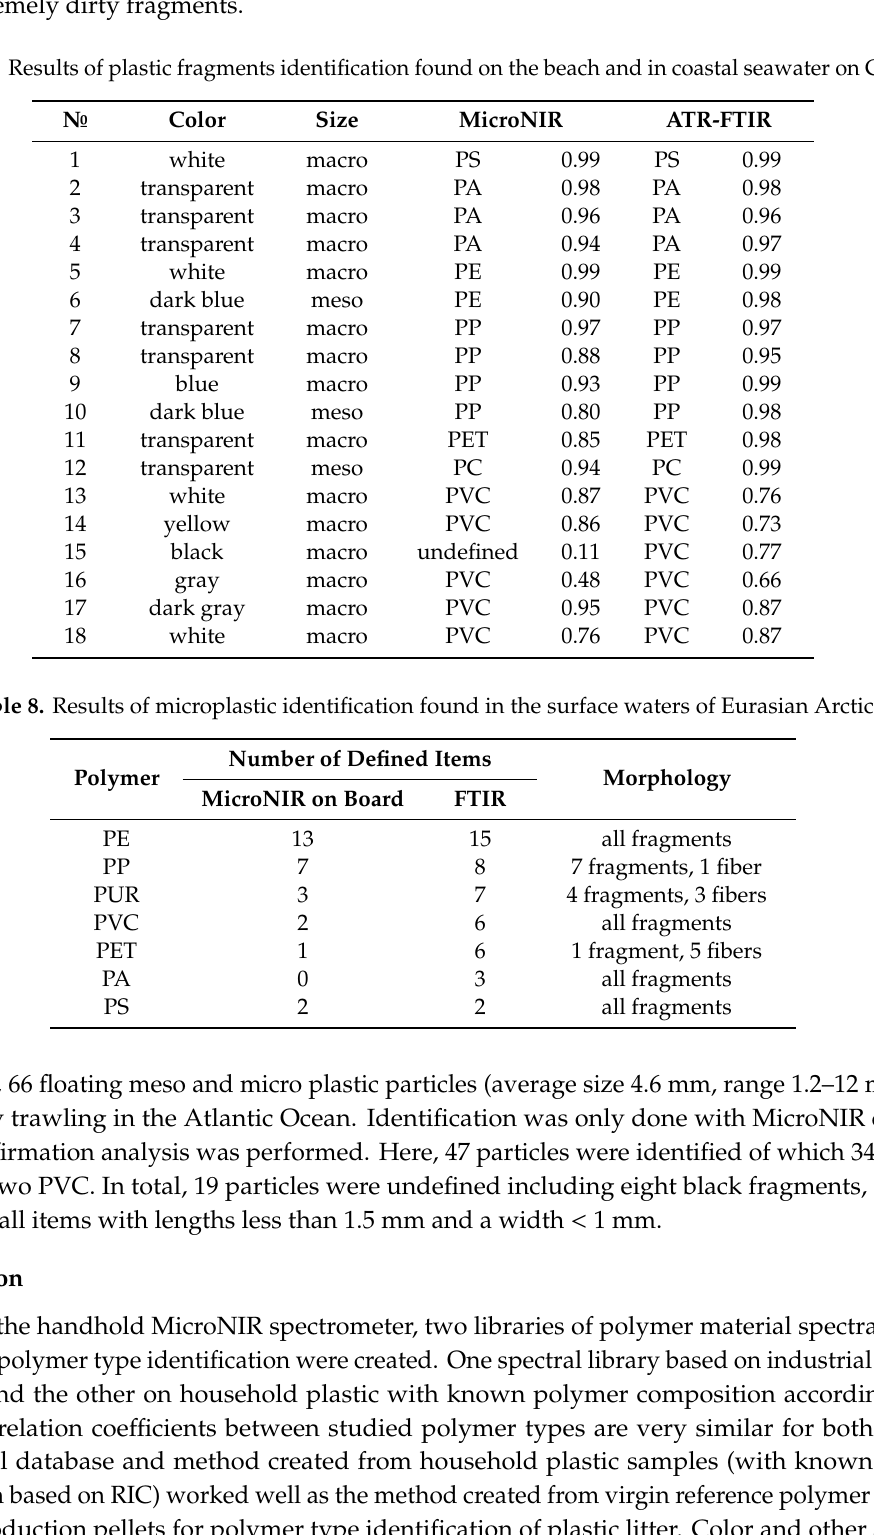
Table 7. Results of plastic fragments identification found on the beach and in coastal seawater on Crete. №